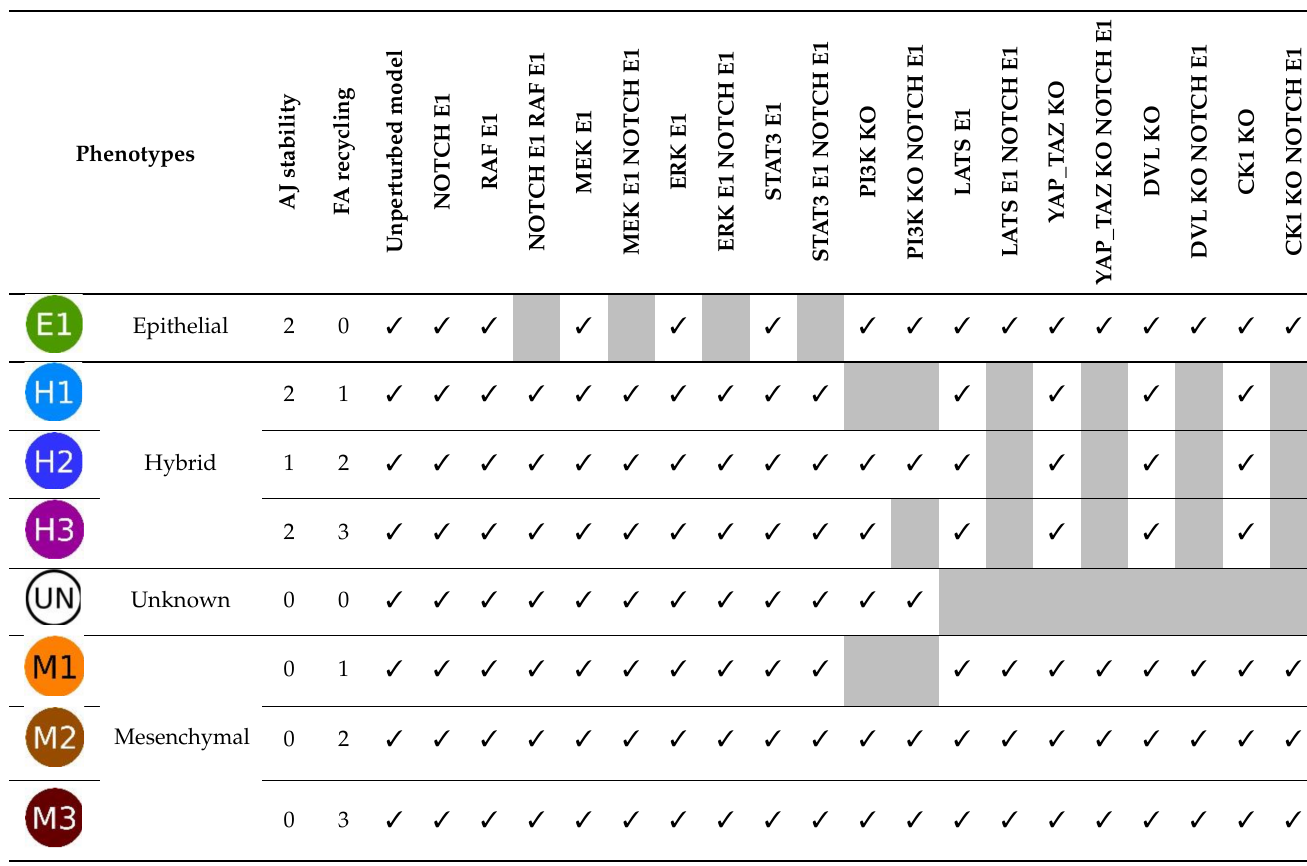
RAS signalling cooperate to prevent the maintenance of an E1 phenotype (Tables 2 and S2). In agreement with these predictions, expressing a constitutive active form of NOTCH or low levels of oncogenic RAS is not sufficient to transform the immortalized HMLE breast cell line, while co-expressing both induces efficient colonies in soft agar and tumours in nice mice [63]. Table 2. NOTCH GoF mutations cooperate with RAS, STAT3, PI3K, Hippo, and WNT signalling in EMT. The first column indicates each phenotype and their classification into the epithelial, hybrid, unknown, or mesenchymal based on the values of the read-outs AJ and FA. The second and third columns indicate the values of the read-outs AJ and FA, respectively. The remaining 20 columns correspond to phenotypes of the unperturbed model or when a single GoF (E1), a LoF (KO) mutation or double mutations involving a NOTCH GoF mutation is introduced. Tick symbol indicates the presence of the corresponding phenotype, whereas grey cells indicate its